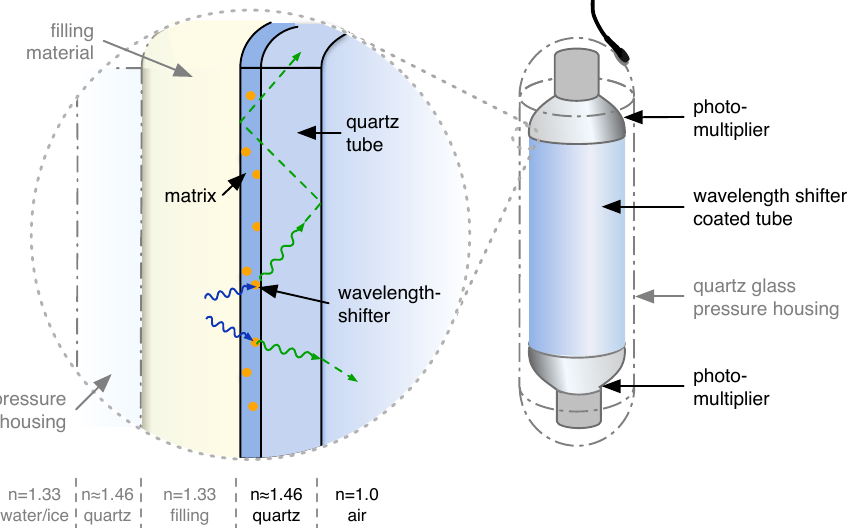
Figure 1. A schematic drawing of the WOM. UV photons are absorbed in the WLS paint layer and are re-emitted as optical photons. If the emission angle of the photons is larger than the critical angle, they are trapped by total internal reflection and are guided along the tube to small, low-noise